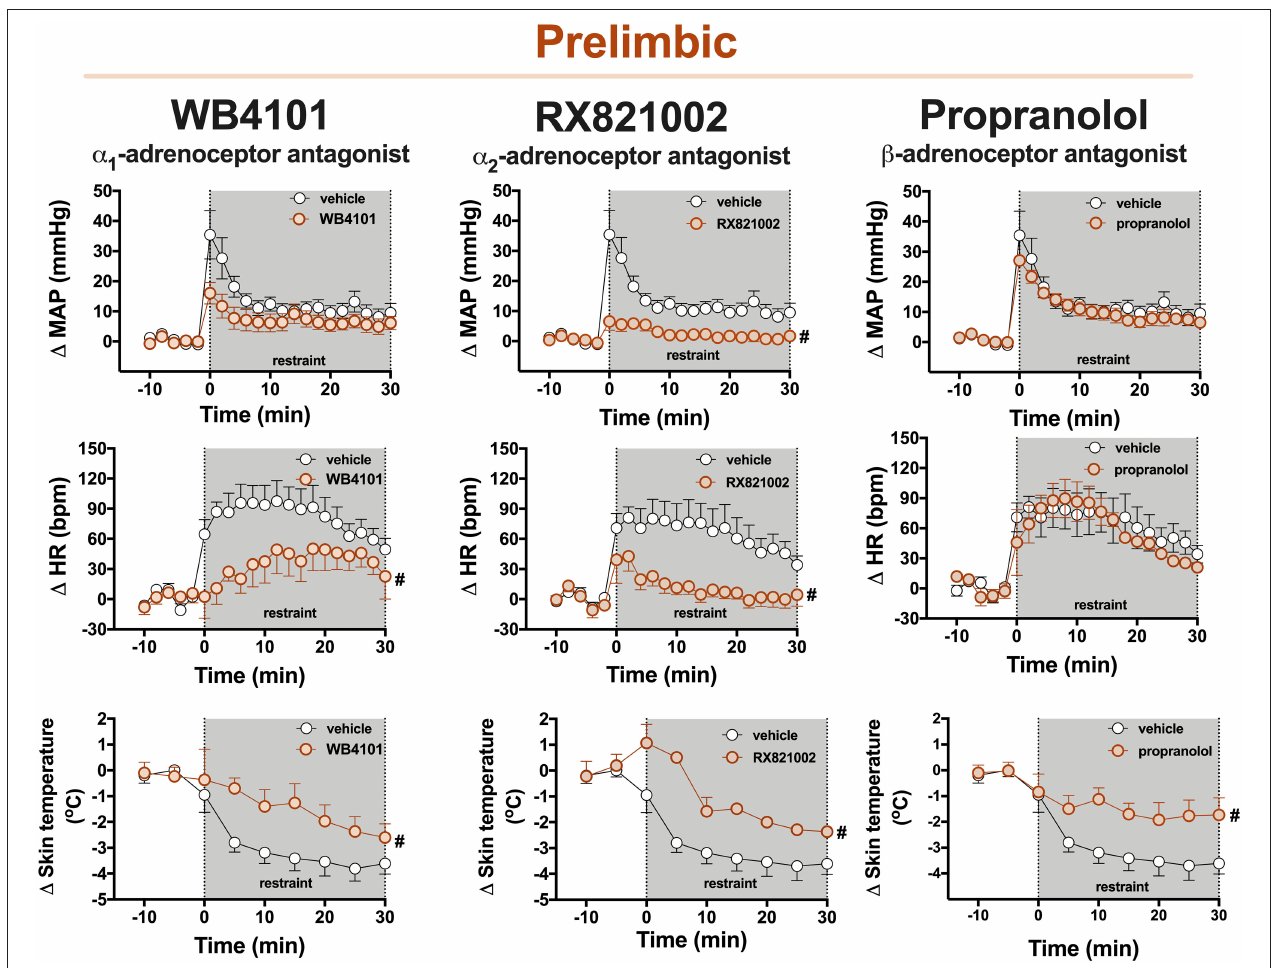
FIGURE 2 | Time-course curves of the mean arterial pressure ( 1 MAP), heart rate ( 1 HR), and tail skin temperature ( 1 skin temperature) changes evoked by an acute session of restraint stress in animals treated with the selective α 1 -adrenoceptor antagonist WB4101 (10 nmol/100 nl, n = 6), the selective α 2 -adrenoceptor antagonist RX821002 (10 nmol/100 nl, n = 6), the β -adrenoceptor antagonist propranolol (10 nmol/100 nl, n = 6), or vehicle (100 nl, n = 7) into the PL cortex. Circles represent the mean ± SEM. # P < 0.05 over the entire restraint stress period compared with the control group (vehicle), two-way